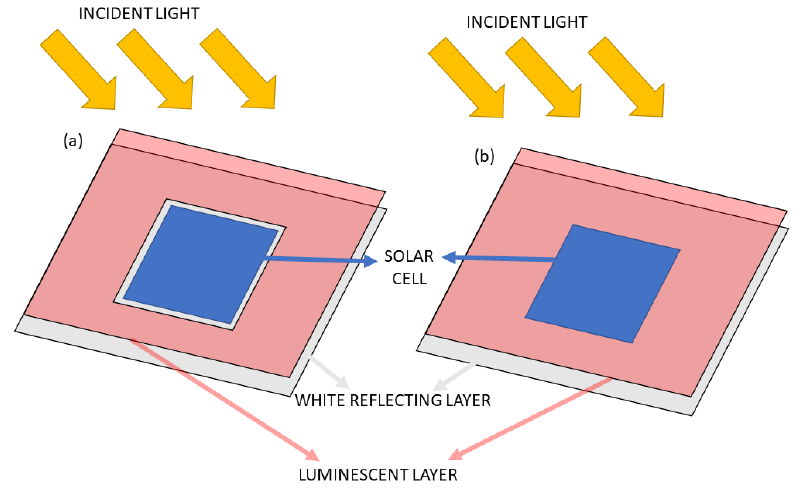
Figure 12. The alternative construction of LSC with a solar cell transparent window; ( a ) and full cover of the module by the luminescent layer ( b ). Based on [78].